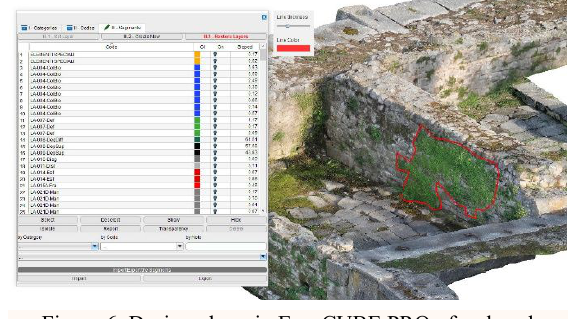
Figure 6. Design phase in EasyCUBE PRO of a closed polyline that identifies the 3D segmentation area